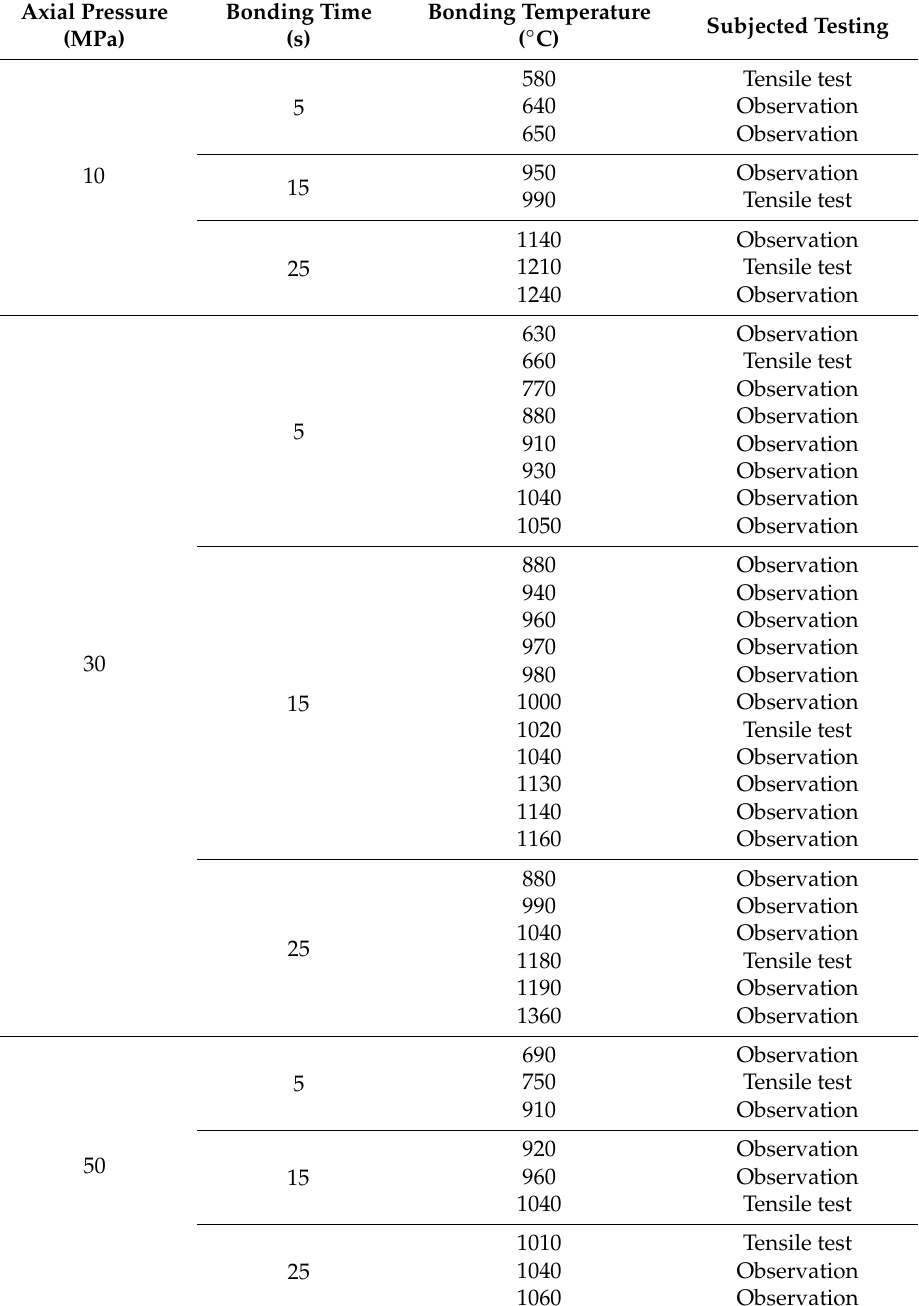
Table A1. Bonding parameters used in this